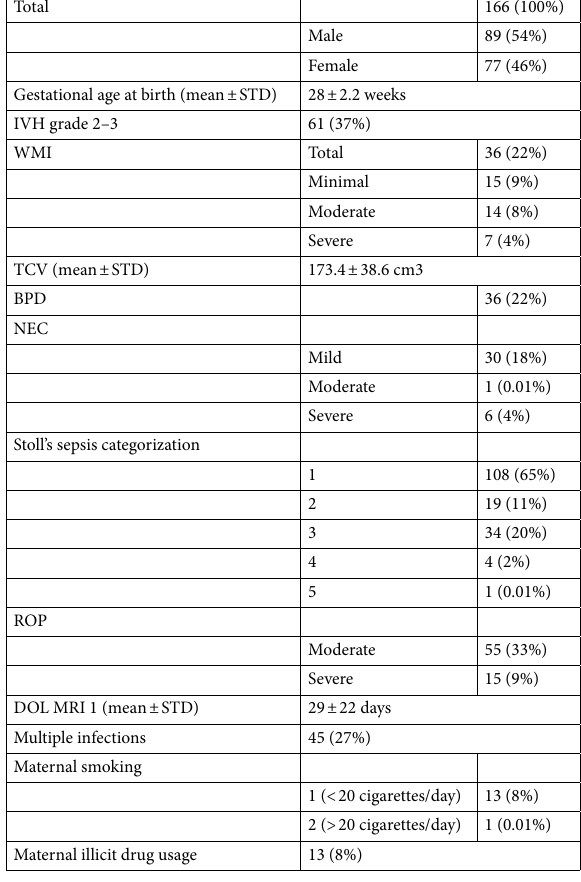
Table 1. Demographic and clinical variables. IVH Intraventricular hemorrhage, WMI white matter injury, TCV total cerebral volume, STD standard deviation, BDP bronchopulmonary dysplasia, NEC